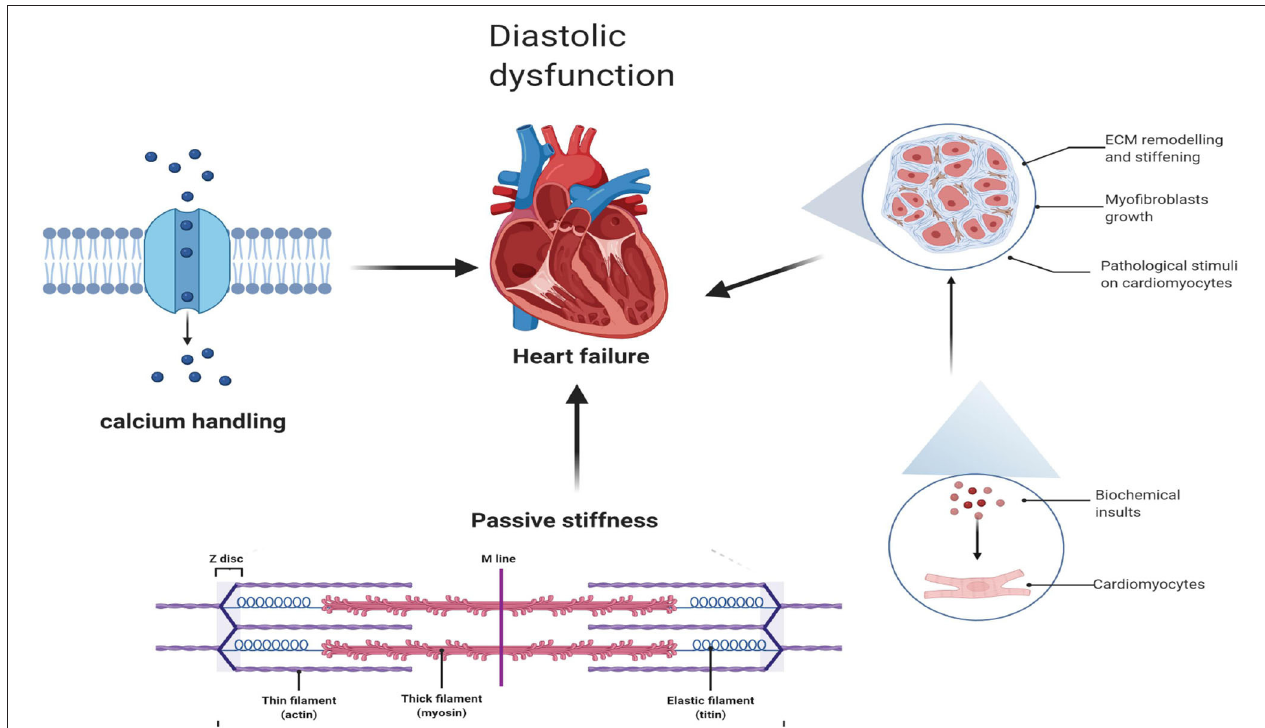
FIGURE 1 | Diastolic dysfunction associated with cardiac fibrosis and Ca 2 +